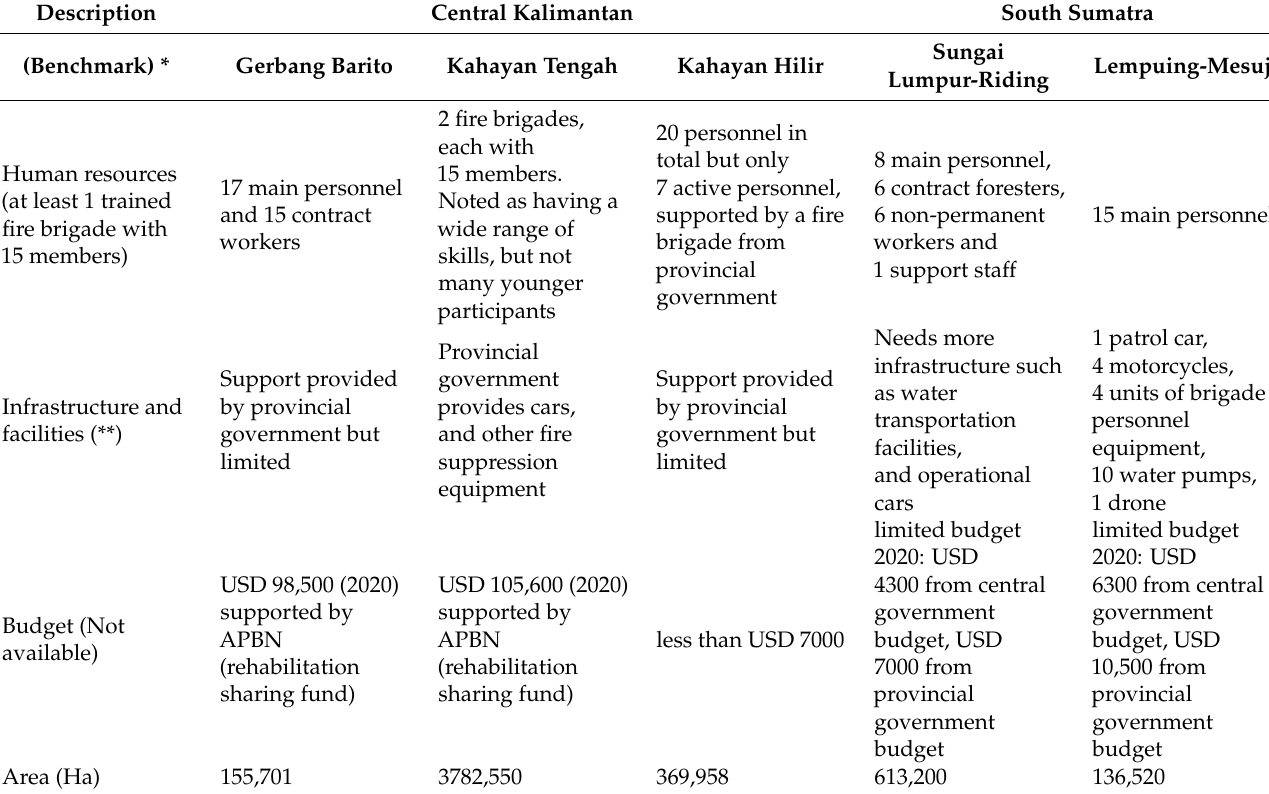
Table 4. Human resources, facilities-infrastructure and budget dedicated to fire management by the five study